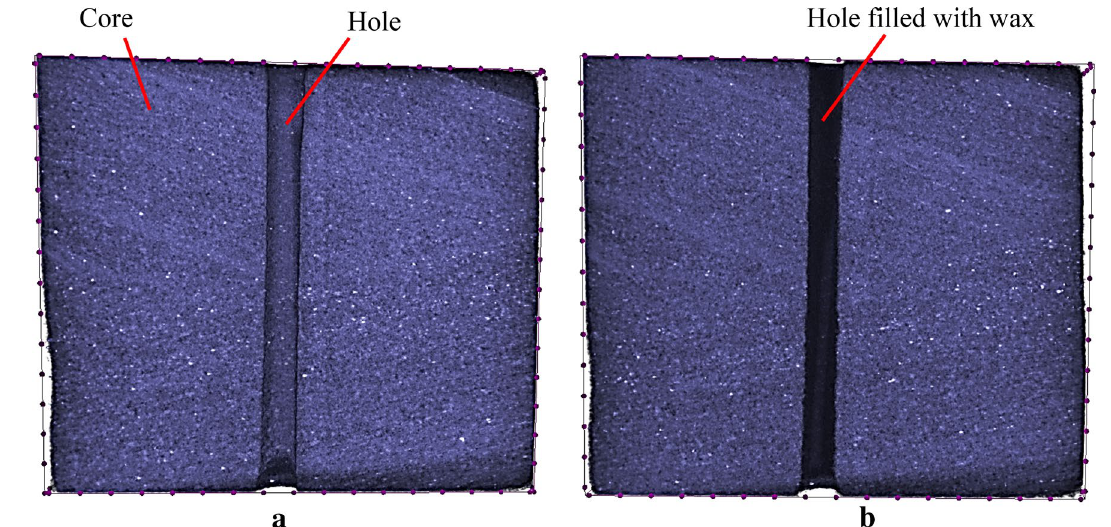
Fig. 1 Images of core with drilled hole ( a empty hole, b hole filled with